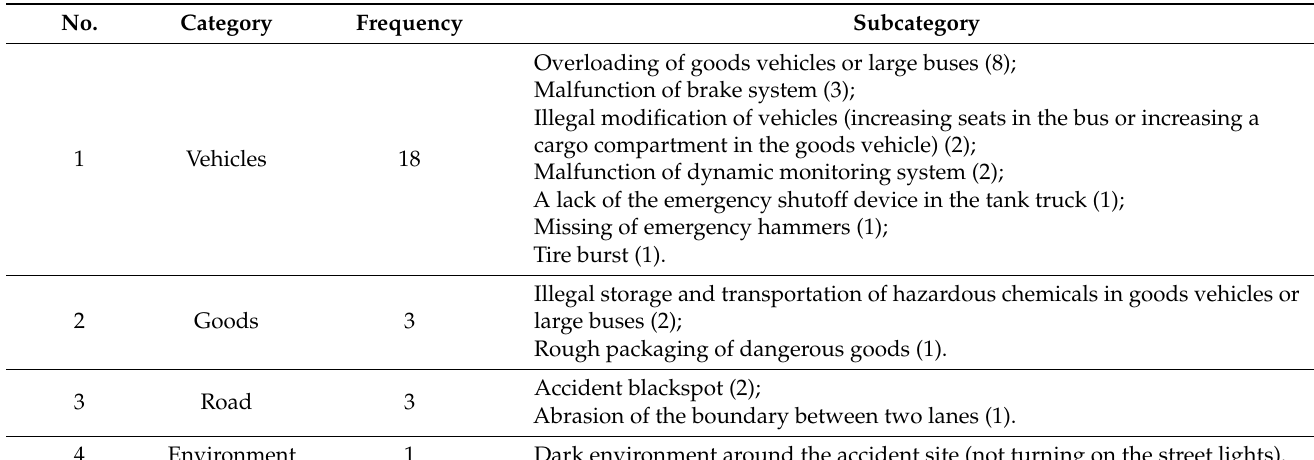
Table 5. Unsafe conditions leading to the commercial vehicle